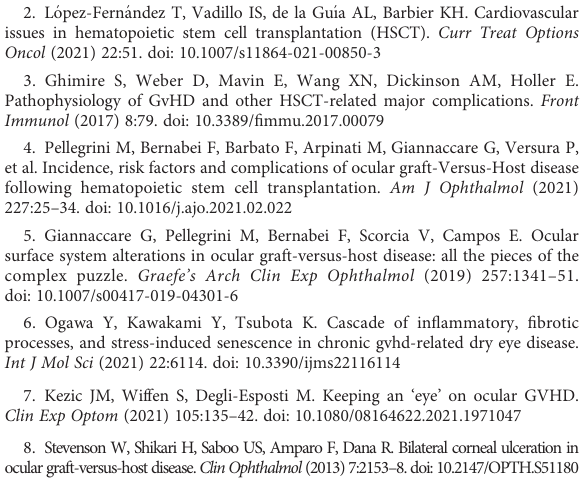
SUPPLEMENTARY FIGURE 1 Histopathology of corneas after keratoplasty. (A) A small amount of squamous epithelium and collagen fi brous stroma were seen in Case 4. (B) Hemorrhage and in fl ammatory cell in fi ltration were seen in Case 5. (C) Collagenization of a small amount of fi brous tissue was seen in Case